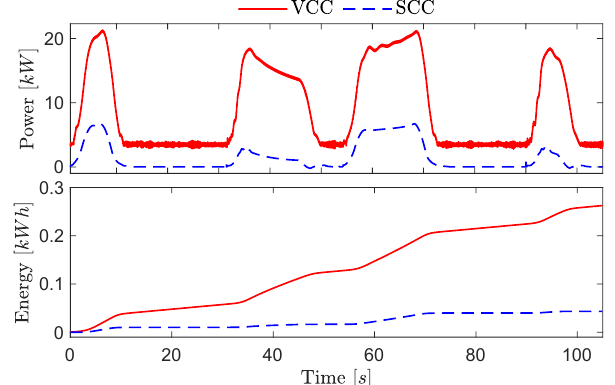
Figure 33: Comparison of the total energy consumption of the self-contained system without and with en- ergy recovery, and with increased efficiency of the